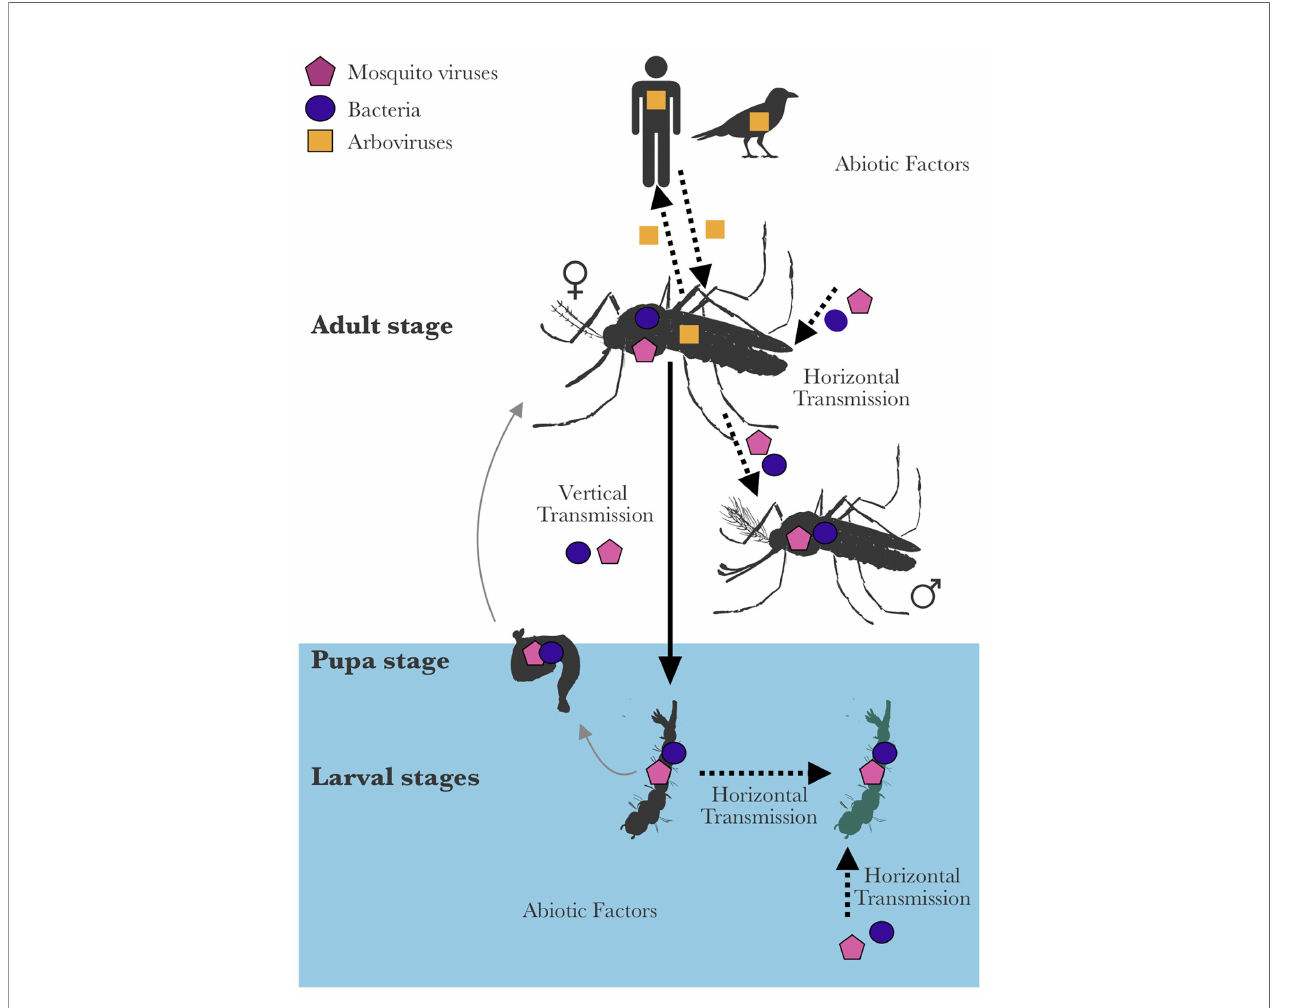
FIGURE 1 | Endosymbiotic interactions of mosquito viruses. Arboviruses are maintained primarily in nature through horizontal transmission and replication cycles in arthropod and vertebrate hosts. Therefore, they primarily infect adult female mosquitoes (arboviruses can also be transmitted vertically, but at very low rates). In contrast, mosquito viruses can be transmitted horizontally (between mosquitoes or from the environment) or vertically (from parents to offspring); and are therefore found in males or aquatic life stages of mosquitoes. They can sometimes be acquired and transmitted with other symbionts. This review discusses the interactions between mosquito viruses and their hosts, the host microbiota, and their place in the host holobiont. The outcome of mosquito virus-mosquito interactions can be context-dependent and in fl uenced by several factors such as transmission routes, host range-host shifts and host immune responses. Interactions between symbionts and symbiont communities can be observed between mosquito viruses and bacteria or other mosquito viruses and also have an impact on the